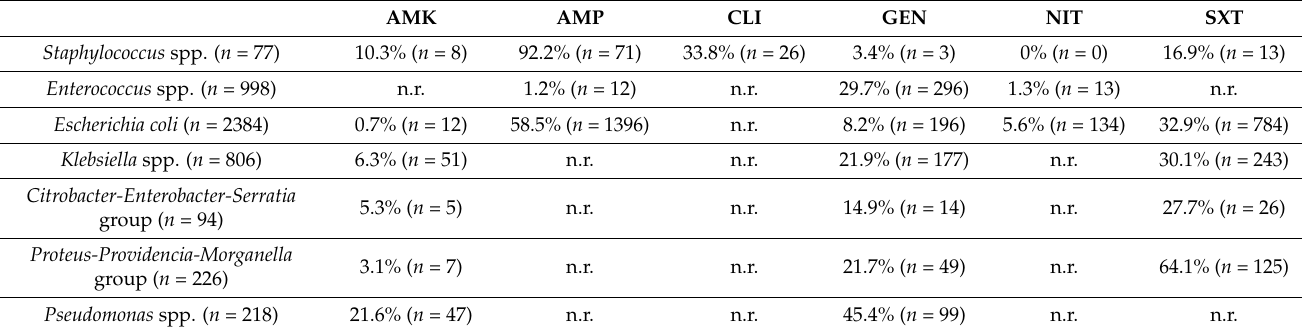
Table 4. Percentage of resistant isolates from outpatient UTIs against WHO Access antibiotics.